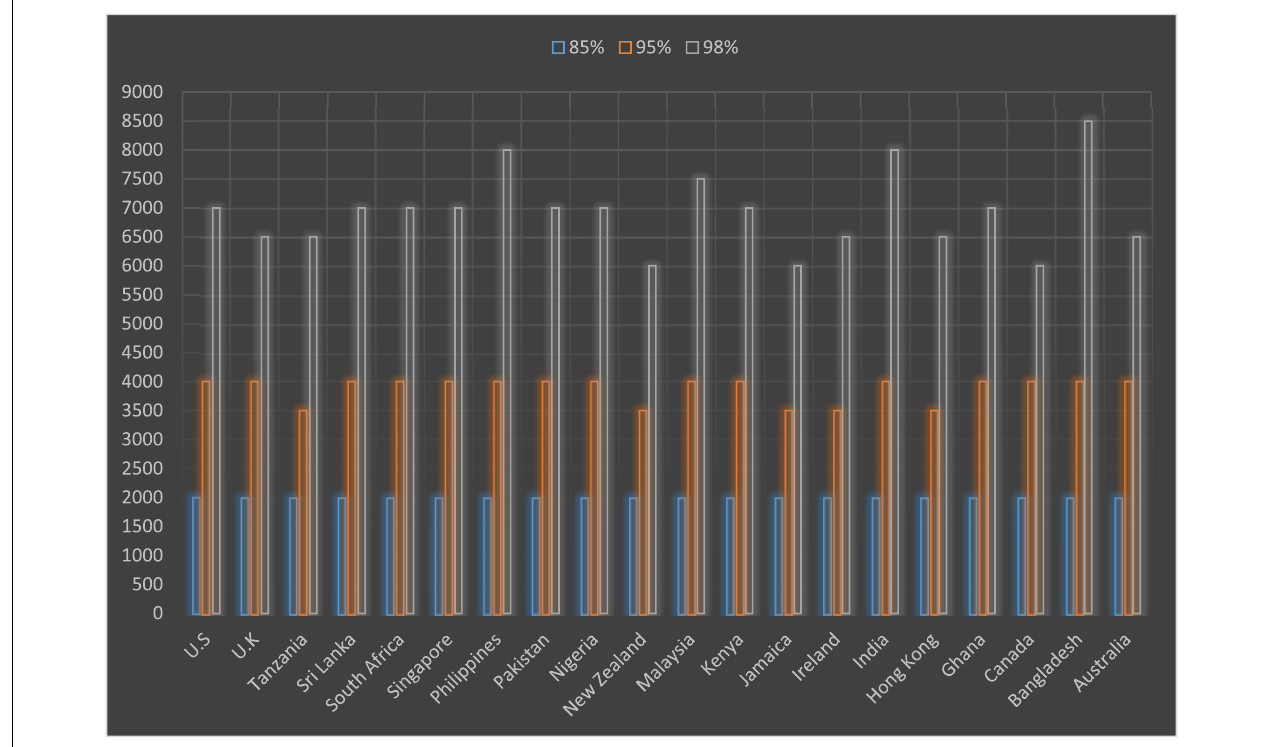
FIGURE 1 | The amount of vocabulary needed to achieve 85, 95, and 98% coverage for online